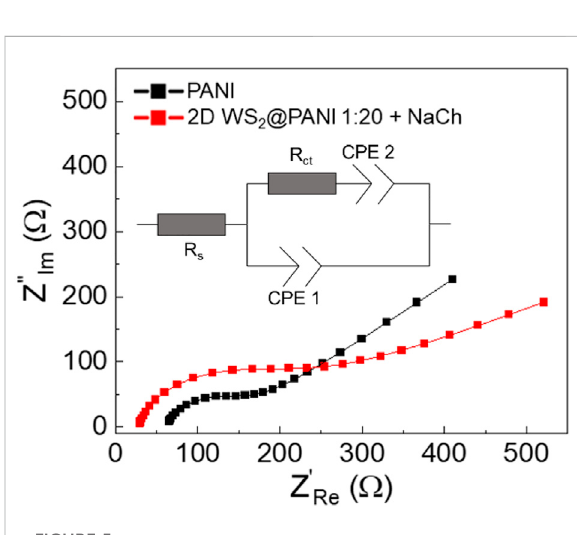
FIGURE 5 EIS analysis-derived Nyquist plots with relative equivalent circuitfortheNaCh-based1:202DWS2@PANInanohybridandfor pure PANI as measured after GCD